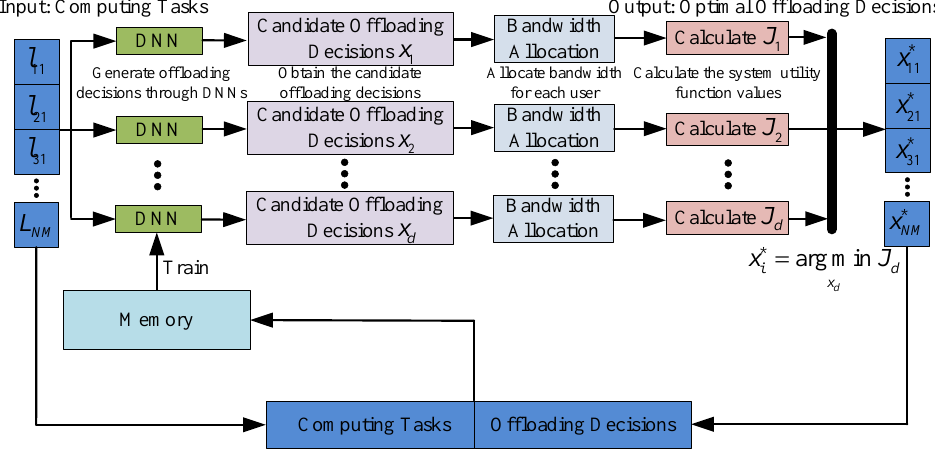
Figure 2. The schematics of the proposed